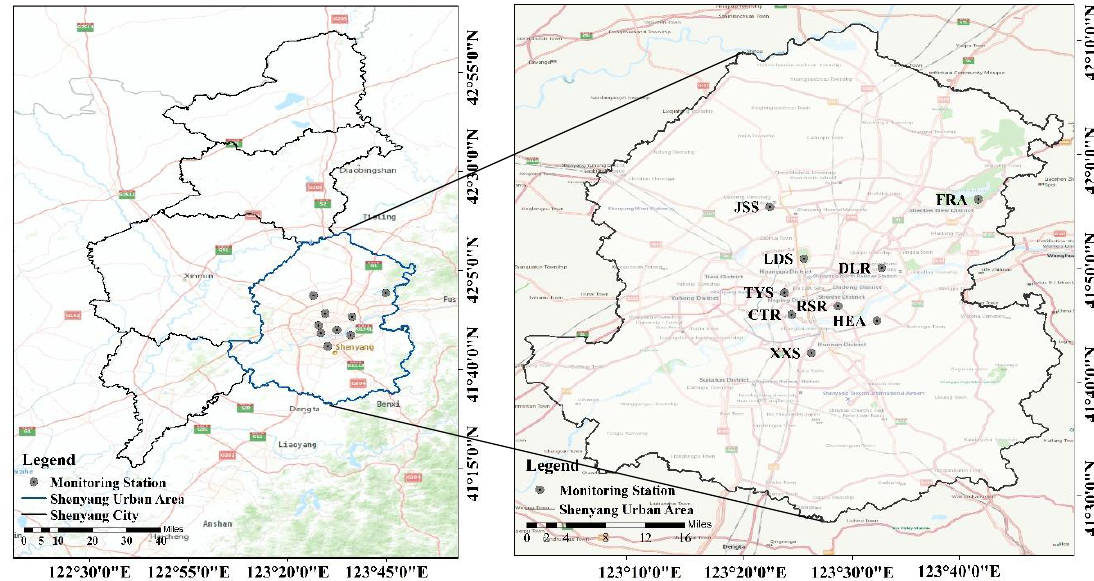
Figure 1. Geographical location of Shenyang with its urban area and monitoring stations.